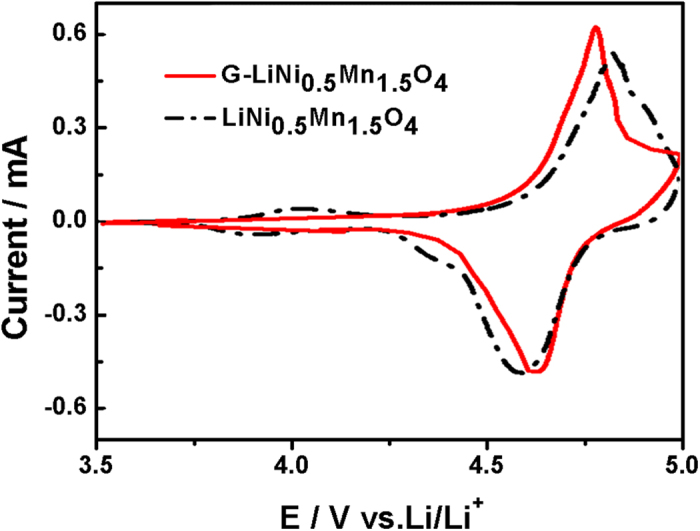
Typical CV curves of the bare LiNi0.5Mn1.5O4 nanorod electrode and the LiNi0.5Mn1.5O4-graphene composite electrode.